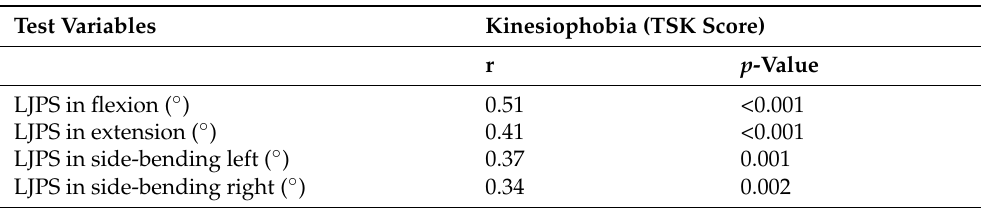
Table 2. Coefficient of correlation between kinesiophobia and lumbar joint position sense in CLBP individuals (n = 83).